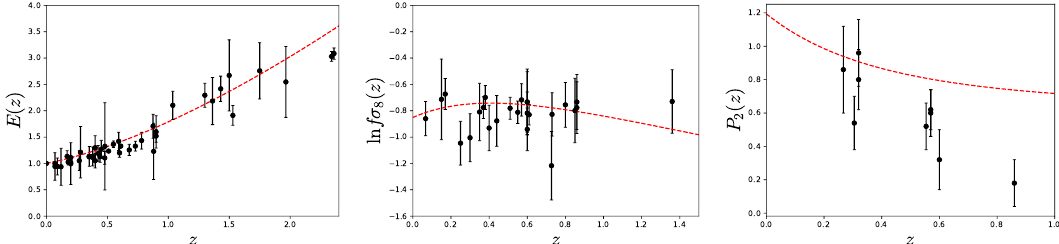
Figure 1. Data sets used in this work (black dots with error bars), plotted with the corresponding theoretical Λ CDM prediction as a function of redshift (solid red line), using a Planck 2015 cosmology. Left panel: E ( z ) data. We used the Planck 2015 value of H 0 to convert some of the data points from H ( z ) to E ( z ) (see main text). Central panel: Plot of the logarithm of the f σ 8 data points. Right panel: Data set for P 2 , obtained using E g data and the relation (136) that converts between different notations. For z > 0.5, we see a larger discrepancy between Λ CDM and the data points, which was also noted in [85] and references